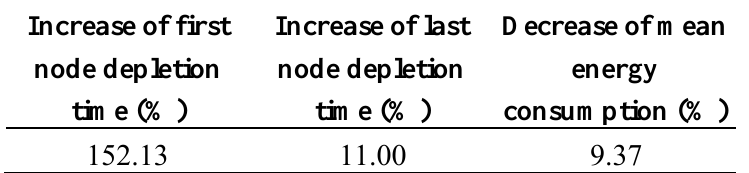
Table 4. Percentage of average enhancement in WSN performance by the use of SHPER in the case of a non uniform initial energy distribution opposed to the case of uniform initial energy